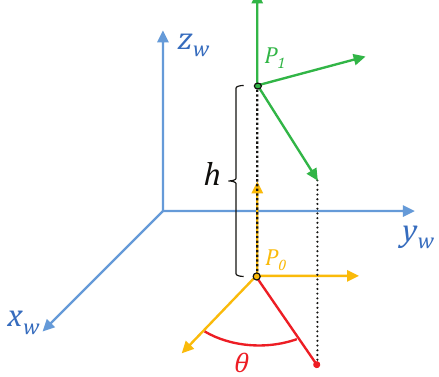
Figure 2. World and robot reference systems. A change in the height is shown (the robot moves from P 0 to P 1